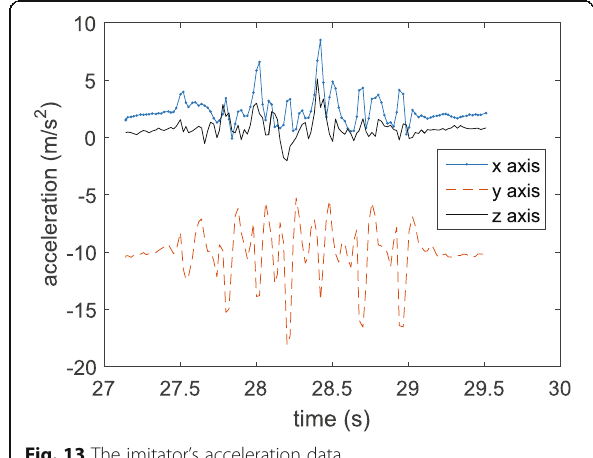
Fig. 13 The imitator ’ s acceleration